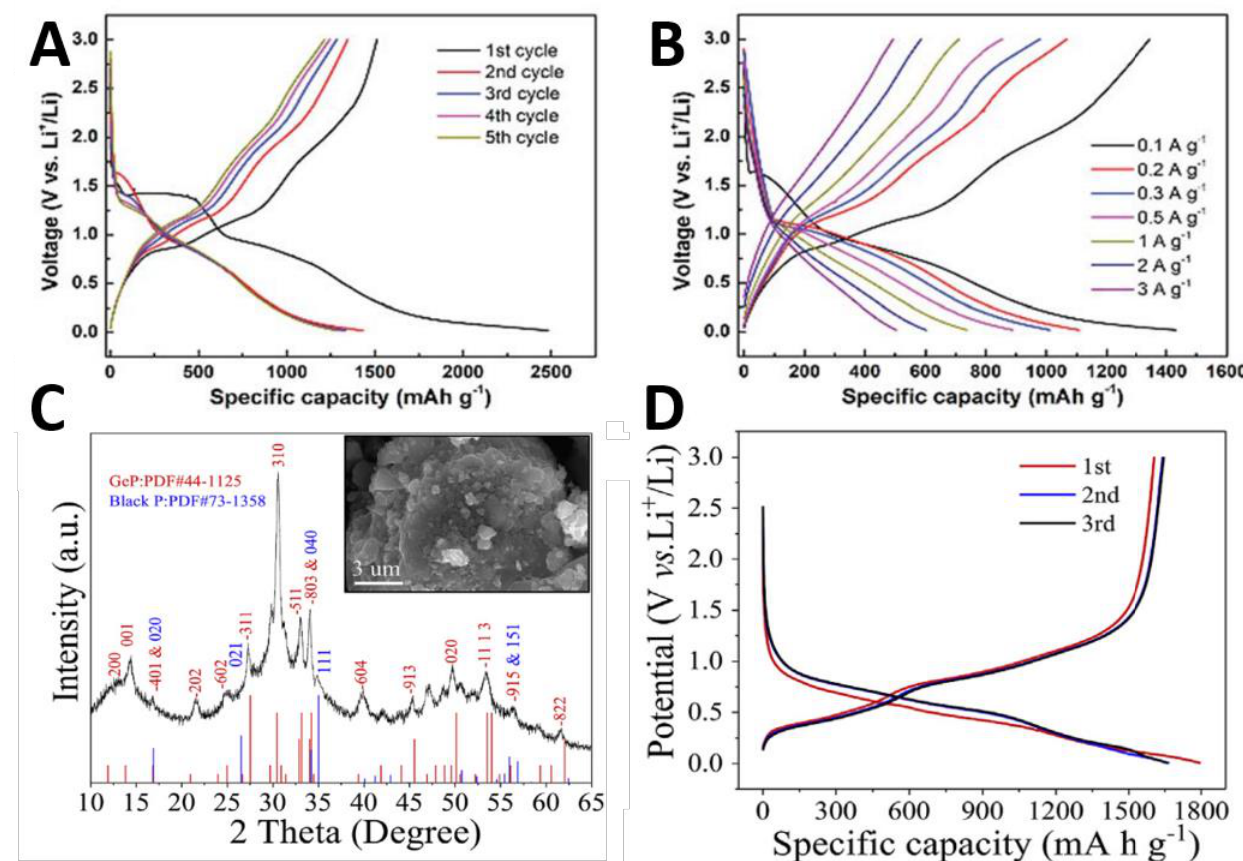
Figure 9. ( A ) Discharge/charge profiles of the first five cycles at 0.1 A g − 1 . ( B ) Discharge/charge profiles at various rates. Reproduced with permission [126]. Copyright 2019, The Royal Society of Chemistry. ( C ) The XRD pattern and the inset shows the morphology. ( D ) The initial three dis- charge/charge profiles of the mixture of 2Ge and 3P milled at 7 h. Reproduced with permission [127]. Copyright 2019, Elsevier.